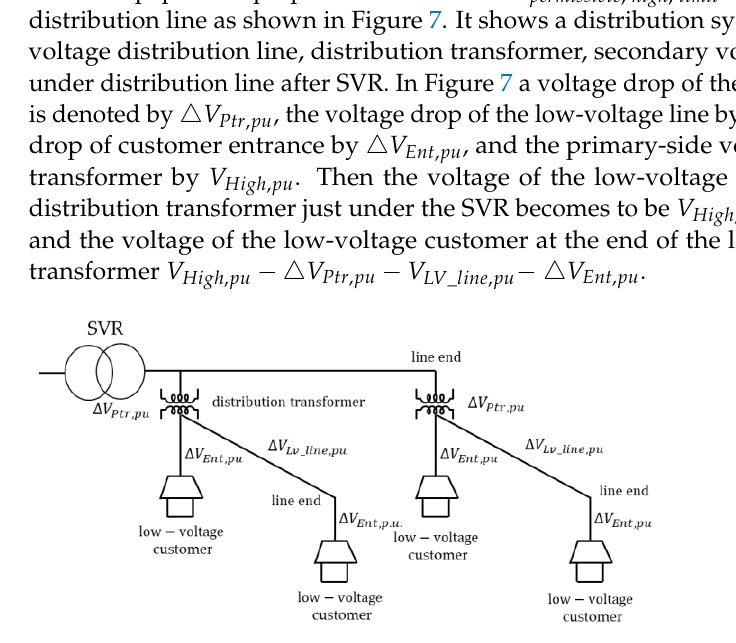
Figure 7. Distribution Line Downstream after SVR.